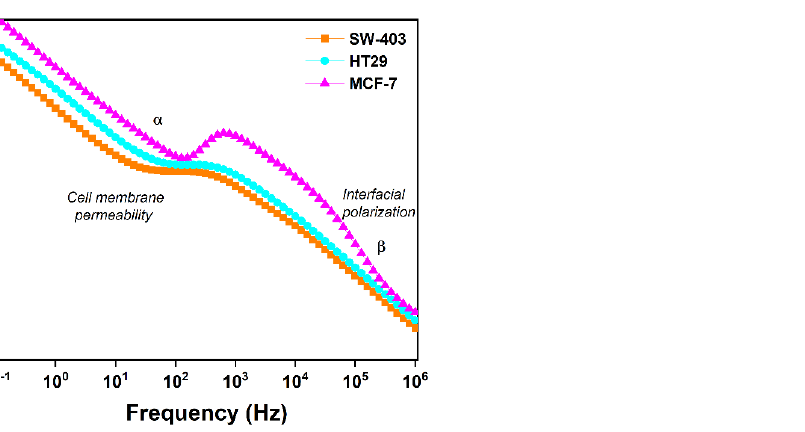
Figure 10. Mechanism of real permittivity dispersion for the different tumor cells: MCF-7, SW-403 and HT-29 cells.